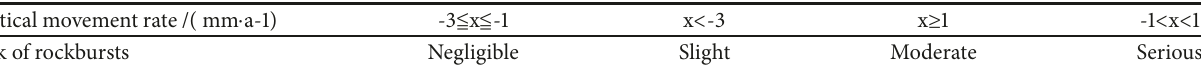
Table 5: Relationship between vertical movement rate and rockburst risk.